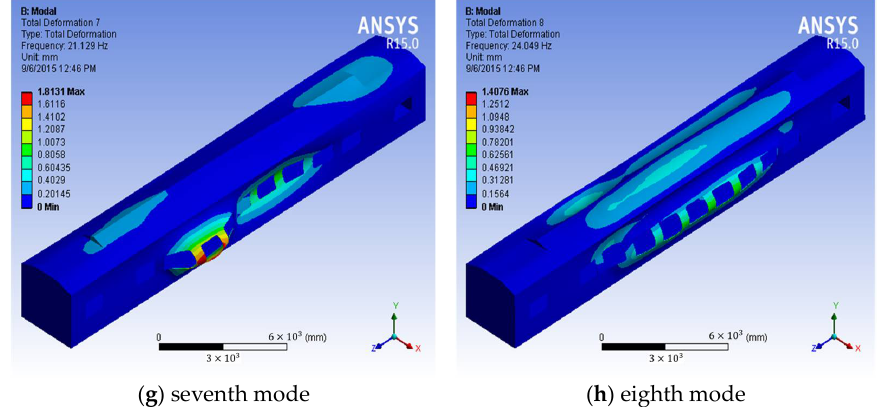
Figure 6. Elastic flexural vibration mode at ( a ) 8.27 Hz, ( b ) 8.33 Hz, ( c ) 13.50 Hz, ( d ) 15.10 Hz, ( e ) 17.70 Hz, ( f ) 18.88 Hz, ( g ) 21.13 Hz, and ( h ) 24.05 Hz.